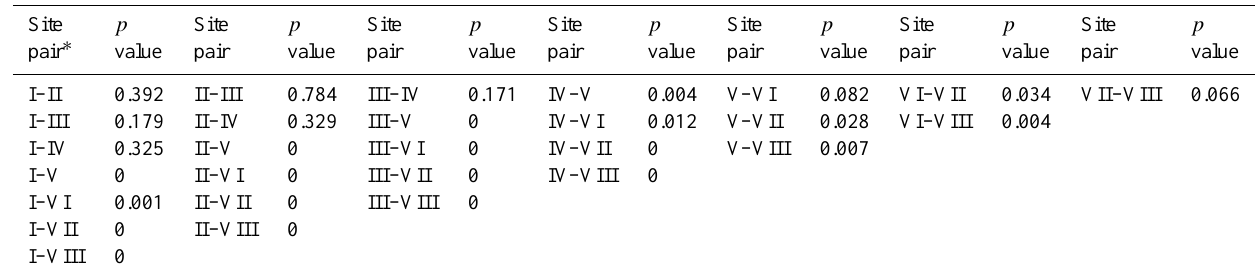
Table 3. p values from the Kruskal–Wallis test for comparison of the similarity of K v values between two test sites. When p value is > 0.05, the similarity is statistically significant.